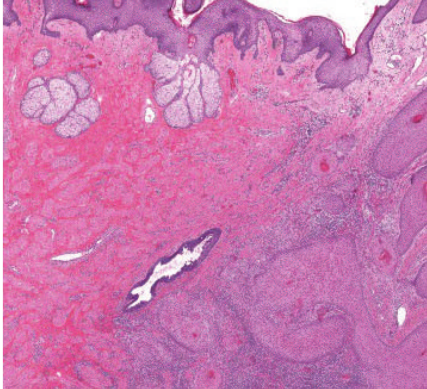
Figure 7: Area extracted from the whole slide image showing extension of tumor deep to the sebaceous glands and a lactiferous duct (HE).